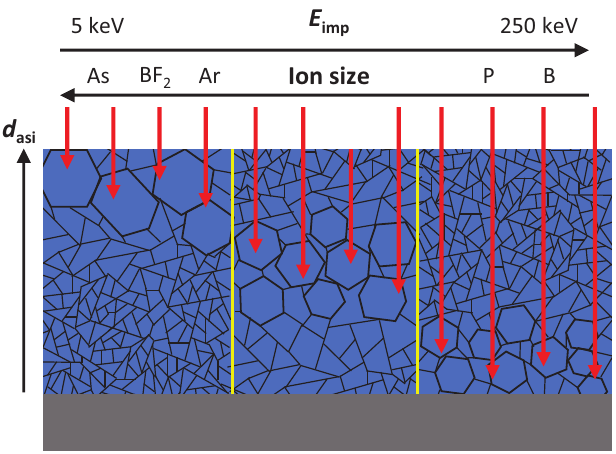
Fig. 7. Simpli fi ed schematic representation of the grain size development as a function of the ion distribution (red arrows) in reference to the silicon surface (grey rectangle), as a function of d asi , the ion type and E imp .